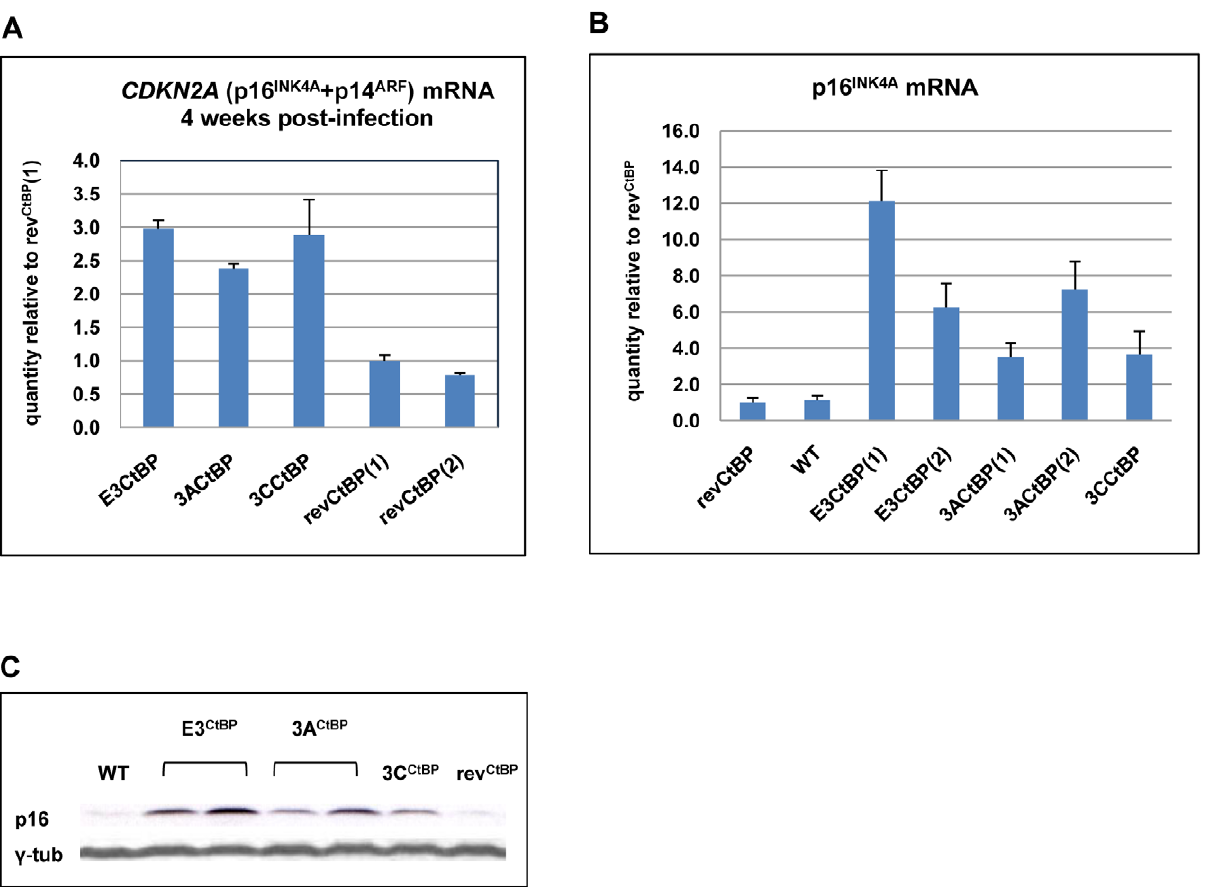
Figure 9. Expression of p16 INK4A is increased in CtBPM LCLs relative to revertant and WT LCLs. ( A ) E3 CtBP , 3A CtBP , 3C CtBP and two rev CtBP LCLs were harvested 28 days after the infection of primary B cells with the recombinant EBVs. RNA was extracted and the relative levels of CDKN2A transcripts were quantified by qRT-PCR. ( B ) RNA was extracted from two established E3 CtBP LCLs, two 3A CtBP LCLs, 3C CtBP LCL, a revertant (rev CtBP ) and a WT-EBV LCL. The relative levels of p16 INK4A transcripts were quantified by qRT-PCR. ( C ) Western blot analysis of protein extracts from two E3 CtBP LCLs, two 3A CtBP LCLs and a 3C CtBP LCL all established from a single donor. A revertant (rev CtBP ) and a WT-EBV LCL are shown for comparison. Levels of p16 INK4A (p16) are shown relative to c -tubulin ( c